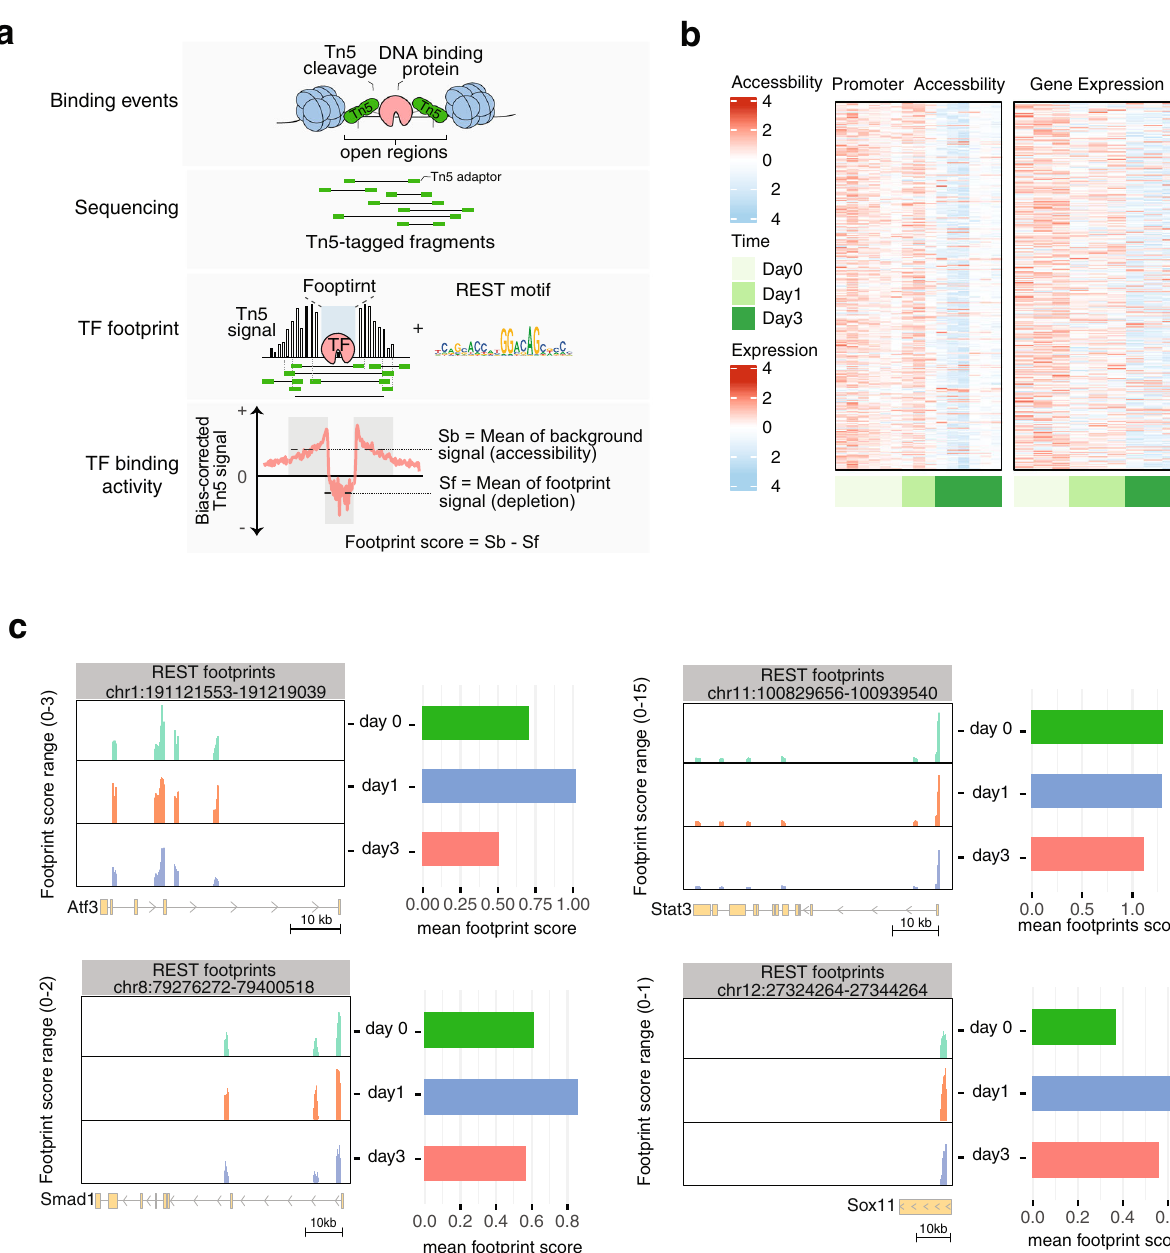
Fig. 5 | REST foot-printing in CNS-injured neurons. a Schematic diagram depictinganalysistoidentifyRESTbindingsitesusingDNAfootprintinganalysisof ATAC-seq data generated from RGCs FACS-puri fi ed at 0 (sham) 1, 3 days following opticnerve crush 54 . During ATAC, Tn5 transposase cleaves DNA free of chromatin- bound proteins such as transcription factors (yellow) and inserts sequencing adapters (green). Tn5-tagged DNA fragments are sequenced to yield reads, and then mapped to the genome to create signals of single Tn5 insertion events (black bars), in which TF binding is visible as depletion of signals (de fi ned as footprint). DNA footprints overlapping with REST motifs are de fi ned as direct REST binding sites. REST binding activities can be quantitated by scoring each footprint ’ s depleted signal and the surrounding chromatin accessibility, correlating with the presence of a TF at its target loci, and the chromatin accessibility of the regions